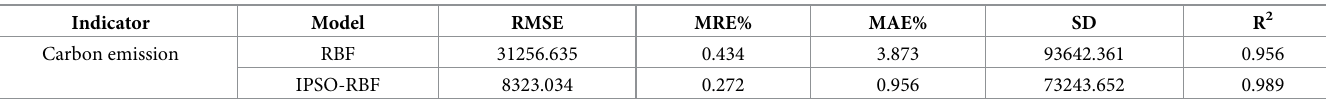
Table 5. Comparative analysis of error indexes of two neural network models. Indicator